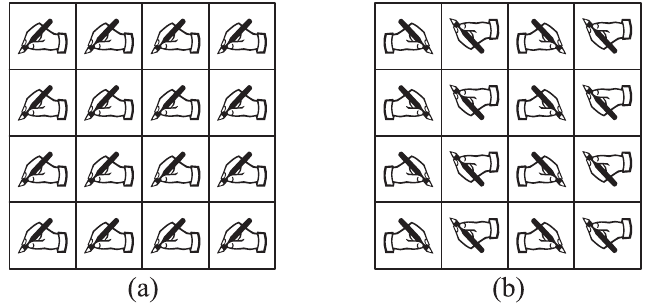
Figure 1. Examples for periodic tilings with marked squares by the transformation groups p1 ( a ) and p2 ( b ).